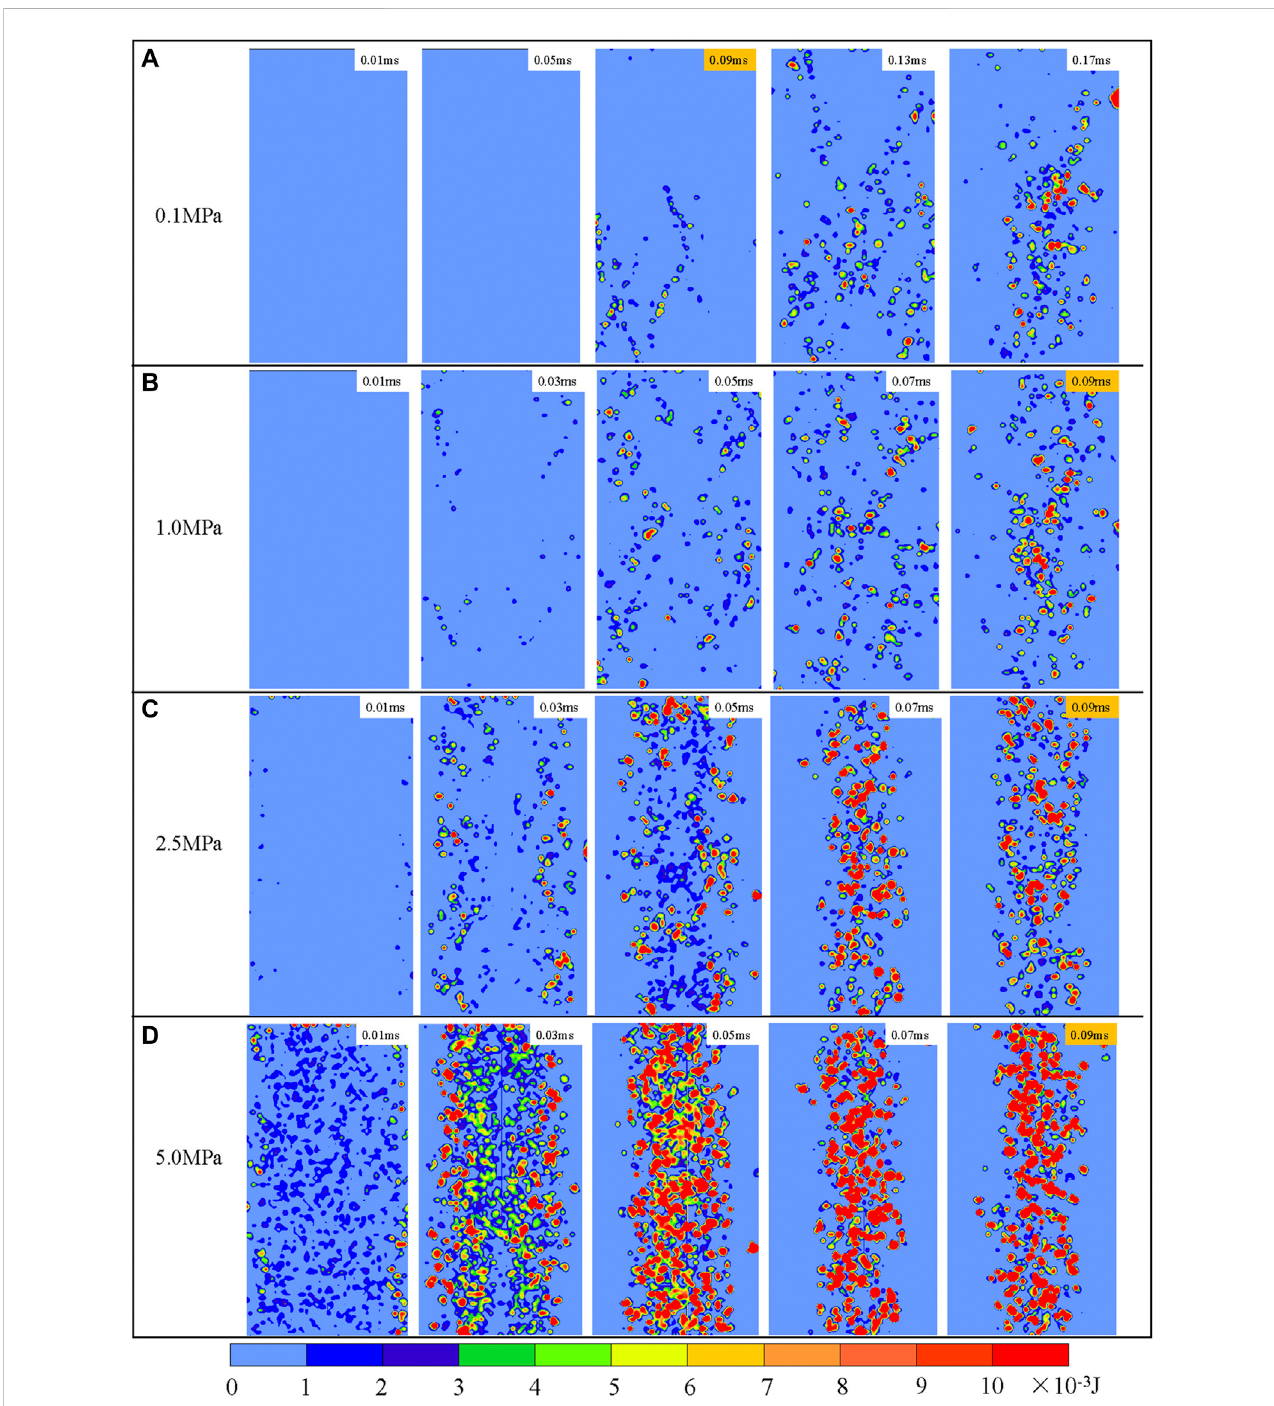
FIGURE 12 Distribution of frictional energy under different pre-con fi ning pressures of (A) .1 MPa; (B) 1 MPa; (C) 2.5 MPa and (D) 5 MPa for different points in time.